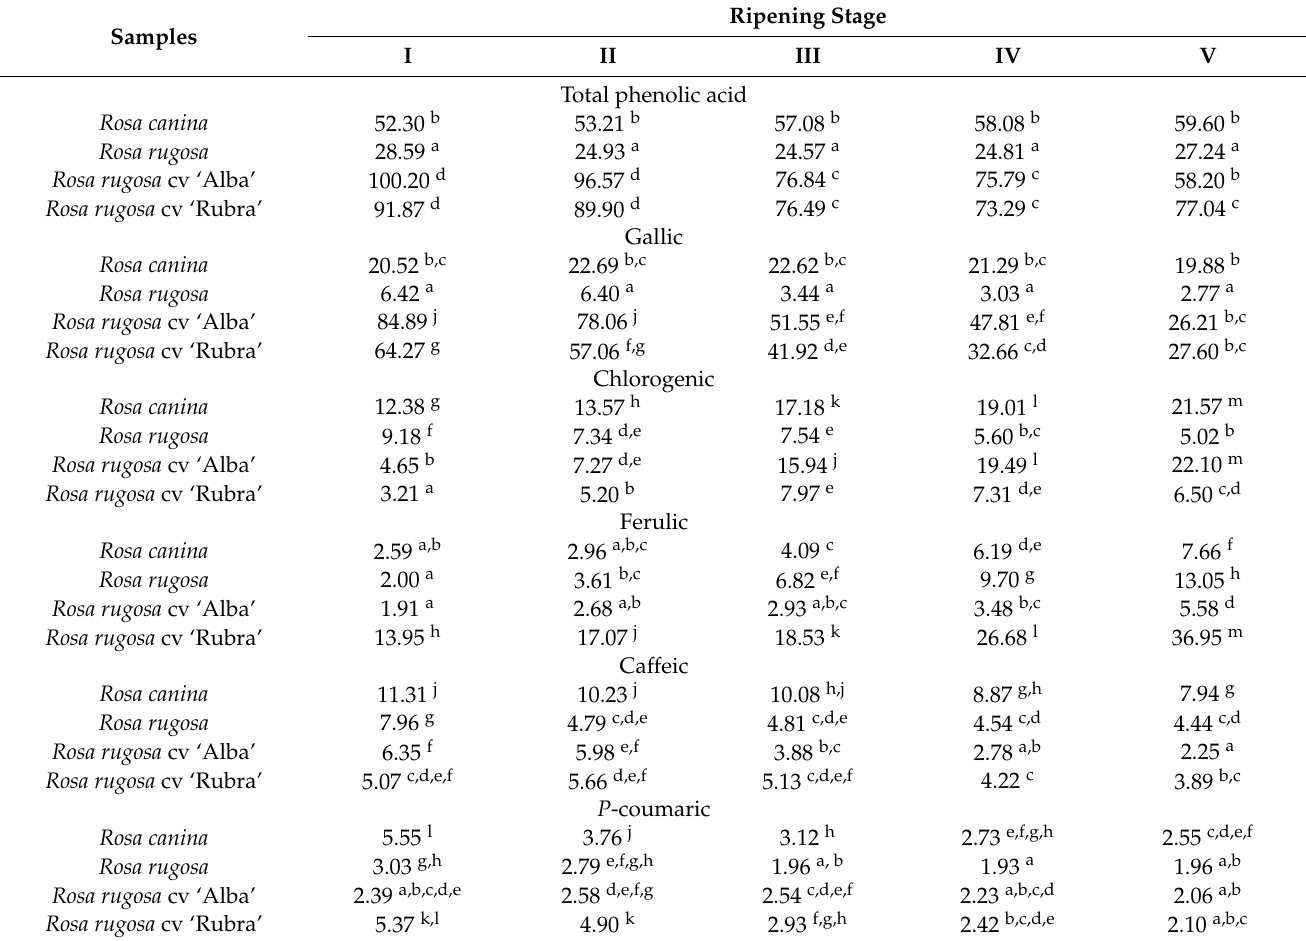
Table 4. Effects of ripening stage on the amounts of phenolic acids in the rosehip fruits, mg 100 g − 1 DW.